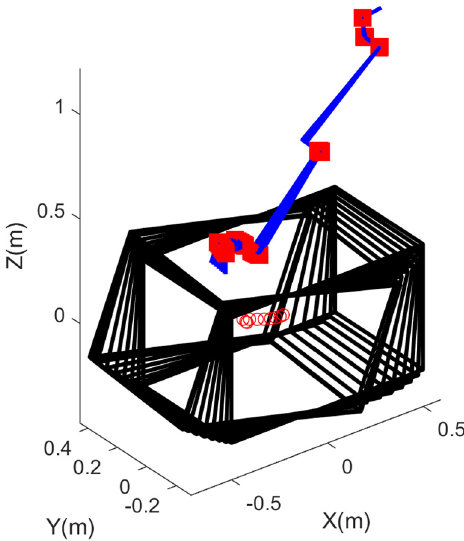
Figure 13. The configuration optimization process considering the risk assessment model.